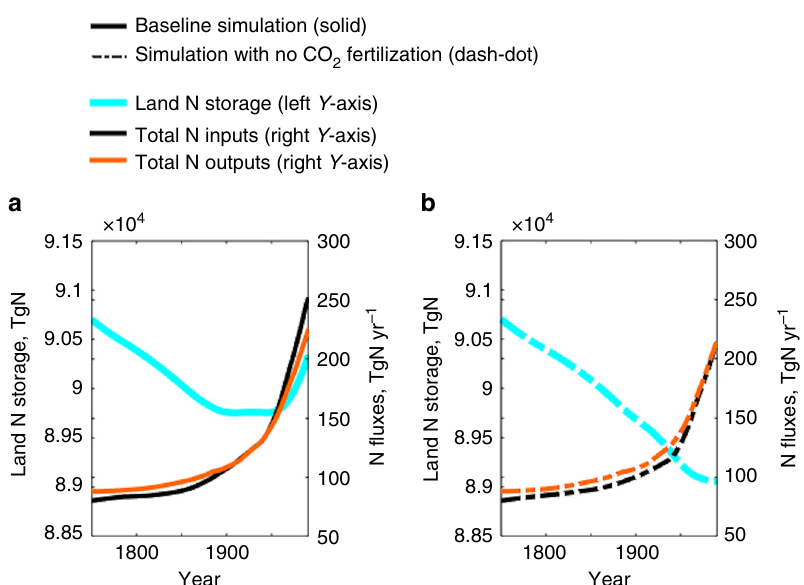
Fig. 2 Global land N storage and fl uxes under different scenarios. a The baseline simulation (solid lines). b The no CO 2 fertilization simulation (dash-dot lines). The colors show land N storage (cyan), total land Nr inputs (black), and total land N outputs (orange). All plots show 30-year moving averages